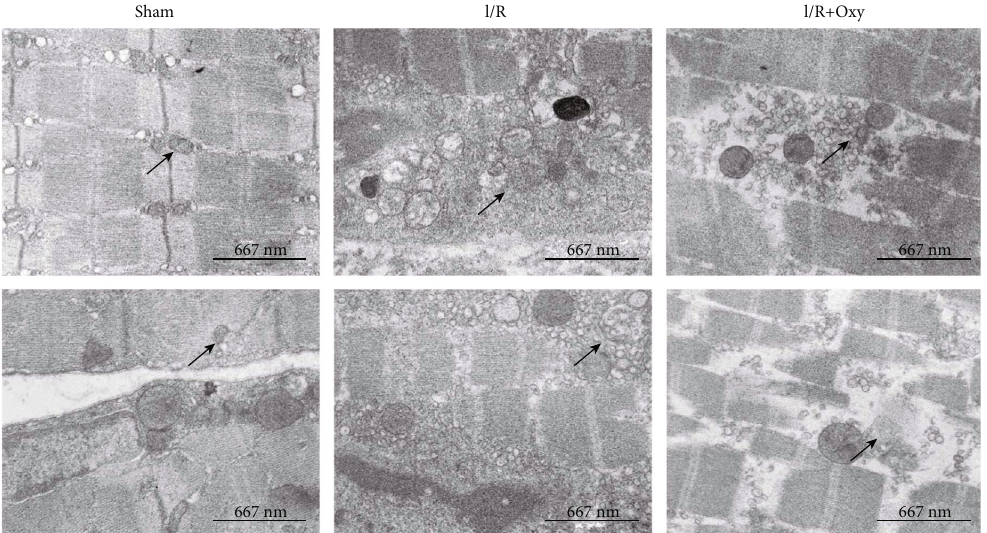
Figure 3: Electron microscope images of the gastrocnemius muscle tissues from all experimental groups. The scale was 667nm at 15,000 magni fi cation. I/R: ischemia-reperfusion; Oxy: oxycodone ( n = 6 in each